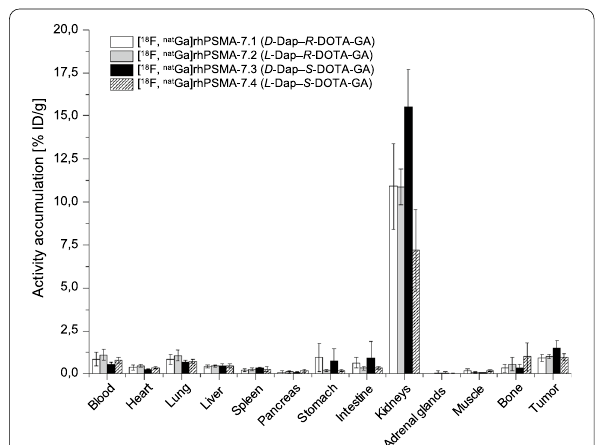
Fig. 3 Biodistribution of [ 18 F, nat Ga]‑rhPSMA‑7 and the isomers [ 18 F, nat Ga]rhPSMA‑7.1 to ‑7.4 at 1 h p.i. in male LNCaP tumor‑bearing Fig. 4 Biodistribution of [ 18 F, nat Ga]rhPSMA‑7.1 to ‑7.4, co‑injected with 2‑PMPA (8 mg/kg) at 1 h p.i. in male LNCaP tumor‑bearing SCID SCID mice. Data are expressed as a percentage of the injected dose mice. Data are expressed as a percentage of the injected dose per per gram (% ID/g), mean standard deviation (n 4 for [ 18 F, nat Ga] ± = gram (% ID/g), mean standard deviation (n rhPSMA‑7.1, n 5 for ‑7.2, n 4 for ‑7.3, n 5 for ‑7.4 and n 3 for ‑7) ± = = = = =